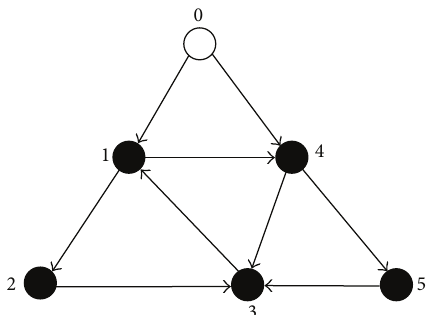
Figure 3: Interconnection topology of five agents and one